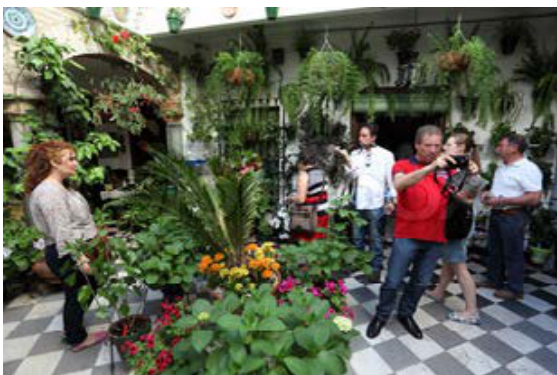
Figure 9. A typical courtyard in the Cordoba historicquarter (Mousli, Semprini, 2015)